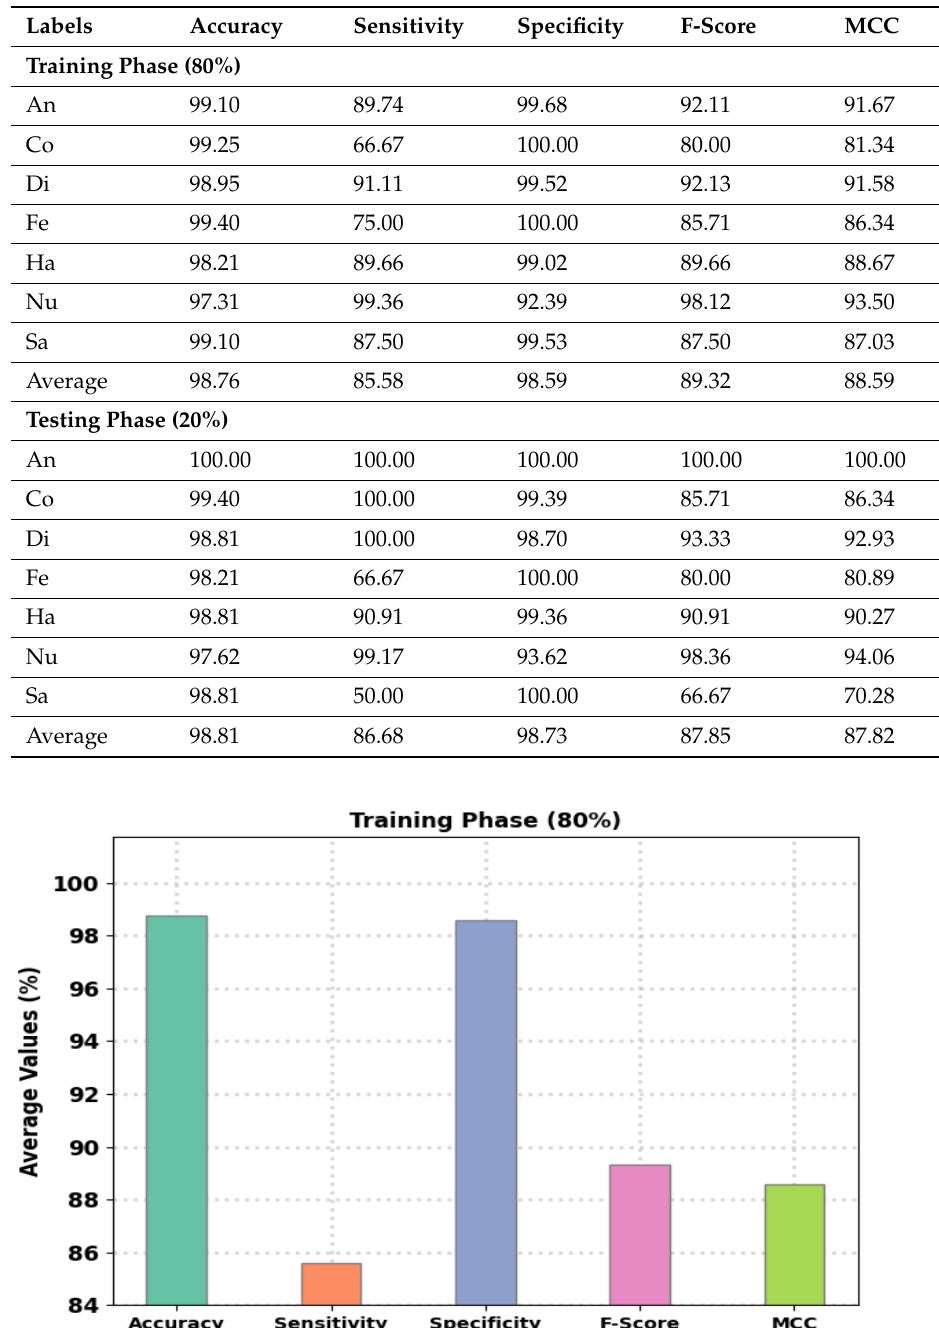
Table 4. Results of the RFER-EADL algorithm for 80:20 of the TR and TS datasets.